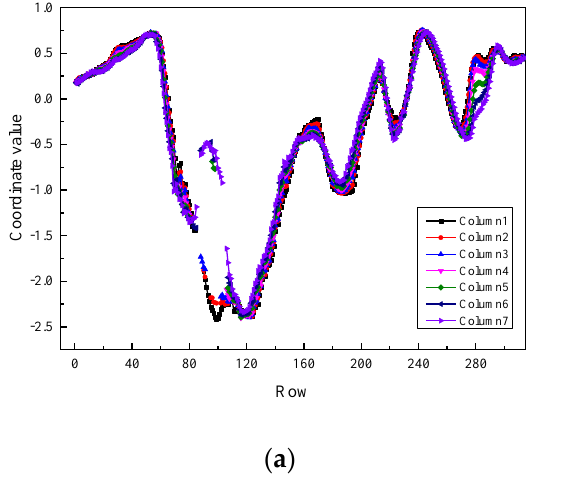
Figure 5. Missing value filling results based on third-order B-spline interpolation method. ( a ) Missing values; ( b ) Repair results of missing values.